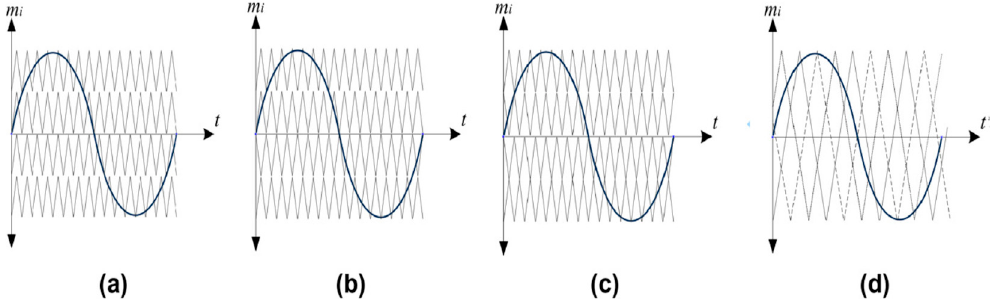
Figure 20. Multi-carrier sinusoidal PWM (SPWM) control methods: ( a ) PD, ( b ) POD, ( c ) APOD, ( d ) PS.